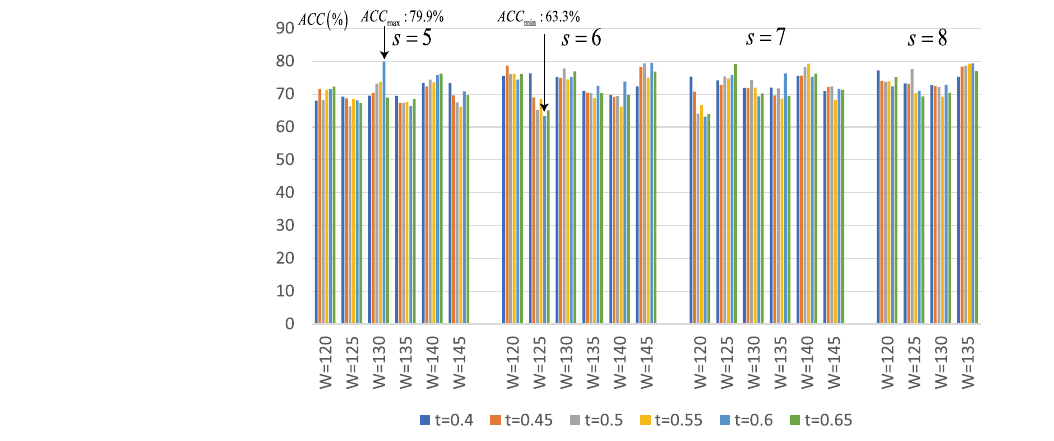
FIGURE 7 | Average classification accuracy (ACC) of SA-GCN with different free parameter combinations (i.e., W, s, and t